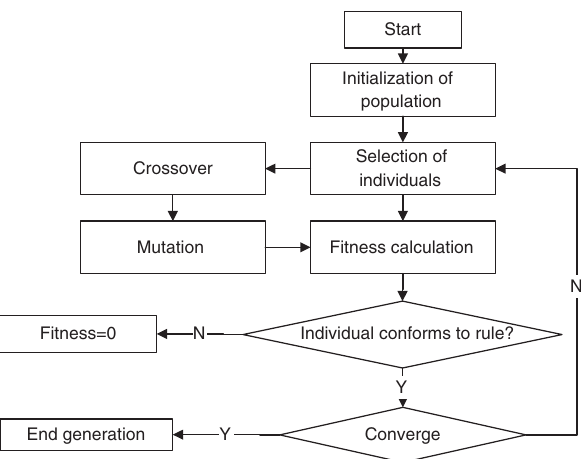
Figure 2 General execution process of zero fitness approach.